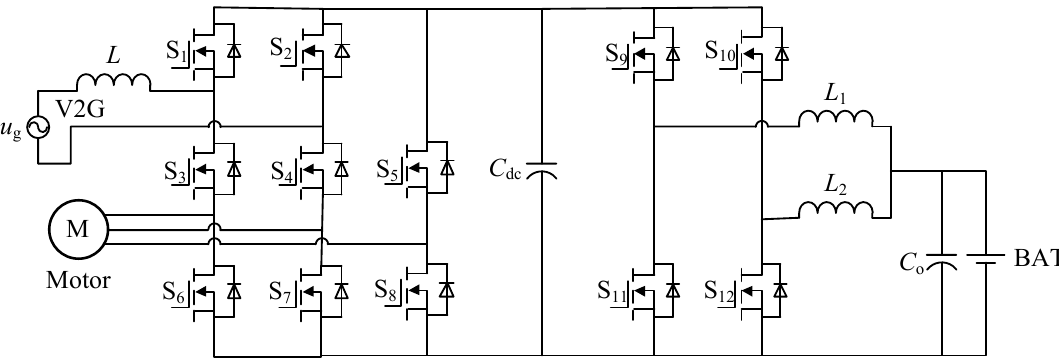
Figure 3. Topology of non-isolated integrated bidirectional charger composed of eight-switch inverter (ESI) and interleave DC-DC converter.